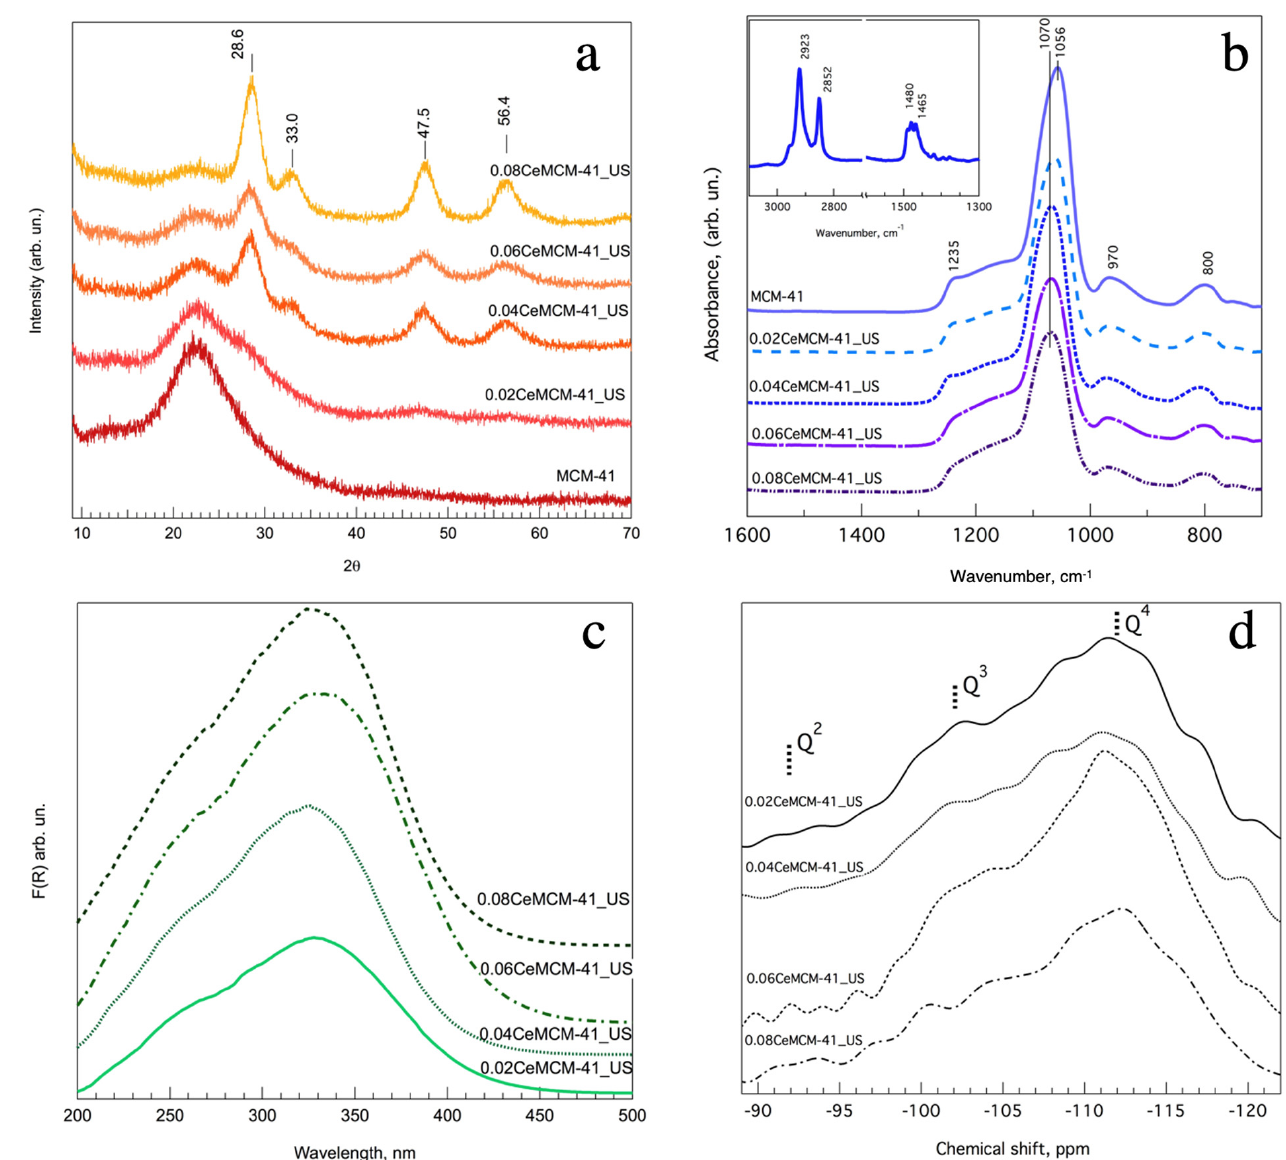
Figure 3. ( a ) X-ray diffraction curves for xCe-MCM-41_US materials. ( b ) FT-IR ATR spectra for calcined cerium-modified mesoporous silica (inset: as-prepared MCM-41). ( c ) UV-visible Diffuse Reflectance spectra for Ce-promoted silica sieves. ( d ) 29 Si solid-state HPDEC MAS-NMR spectra of cerium modified mesoporous silica